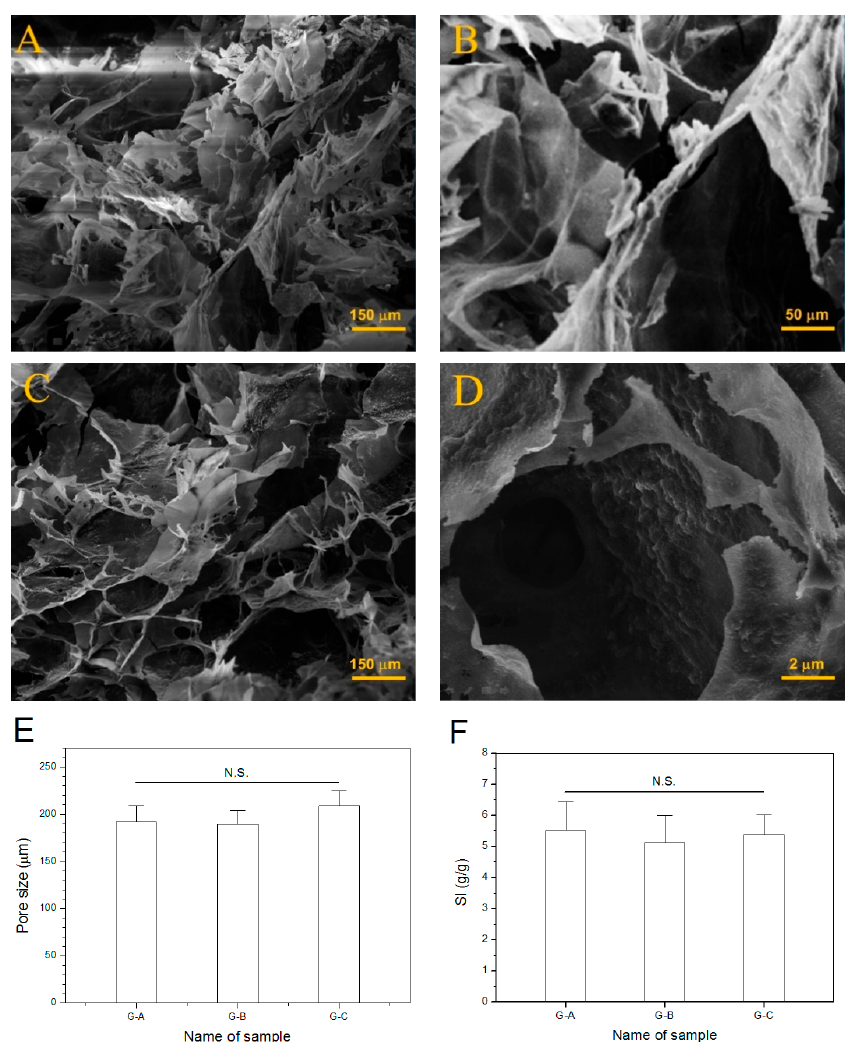
Figure 6. SEM micrographs (( A , B ), G-A gel; ( C , D ), G-C gel), average pore-size ( E ) and swelling index ( F ) of BG/ALG–POL/SF dry gels (see Table 3 for parameters of gels; N.S., no significance).